Question: Describe this figure in one sentence.
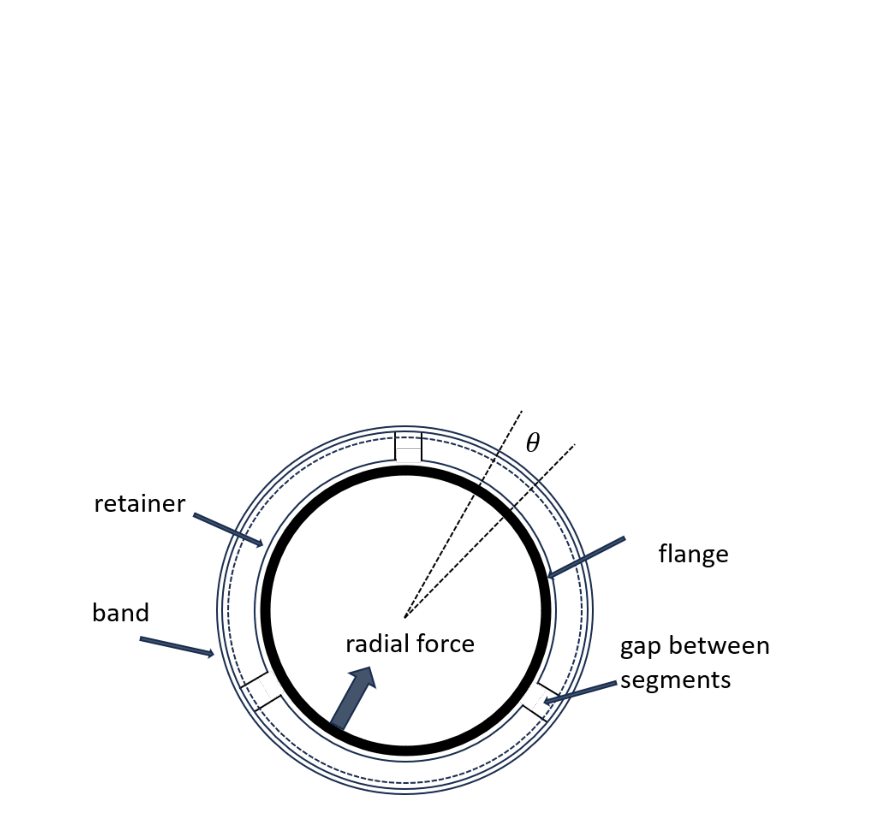
Answer: View looking down the cylindrical axis of a generic Marman clamp. The flange is part of the cylindrical object that is being clamped together. The gap between the segments of the retainer ensures that hoop stresses in the retainer are minimized. The band is either stretched over the retainer such that the induced hoop stresses in the band induce compressive force on the retainer, or the compression may be induced by splitting the band at some point and pulling the pieces together using a screw mechanism.